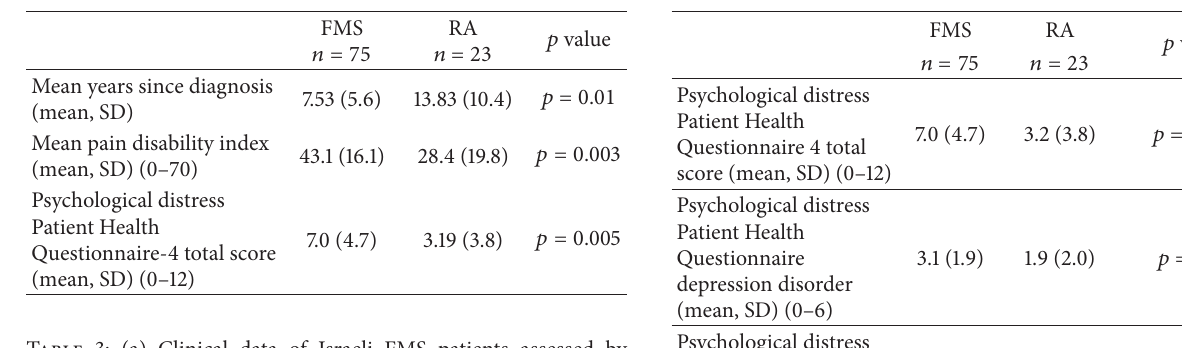
Table 2: Comparison of clinical data of Israeli FMS patients and RA patients.